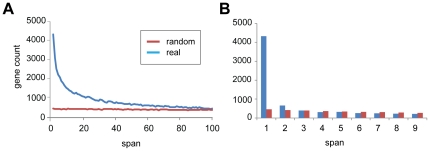
Frequency distribution of distances between structurally related genes.(a) Frequencies of distances between structurally related genes across the human genome (blue) as compared to the same data generated from randomly permuted genomes (red). (b) Frequencies of distances to the nearest structurally related gene for all human genes (blue) as compared to the same data generated from randomly permuted genomes (red).